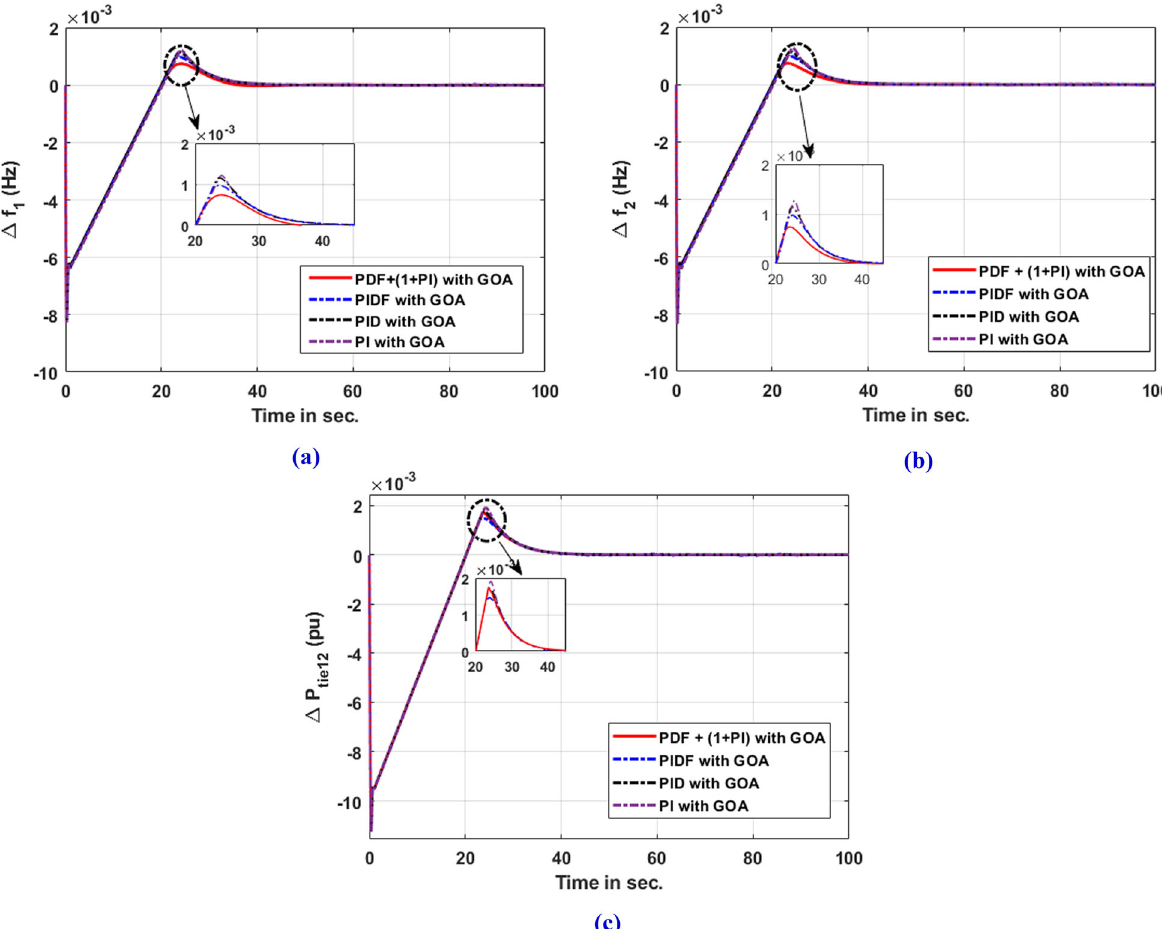
Fig. 5 Dynamic responses of different GOA optimized controllers with 1% SLP and IPFC device in each